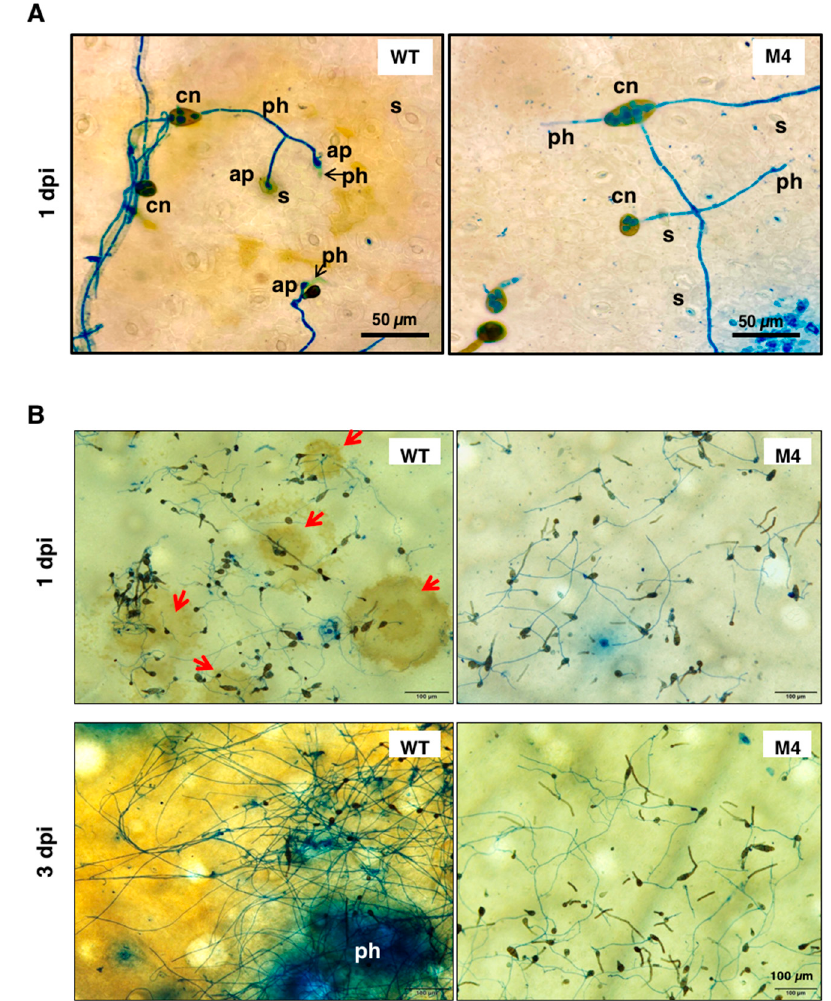
Figure 7. Light microscopy observation of conidia germination on the surface of calamondin leaves. ( A ) Conidia of wild type (WT) and the ∆ pex6 -M4 mutant were placed on citrus leaves and observed by light microscopy, revealing the germination of conidia (cn), the formation of appressorium-like structures (ap) and the penetration of hyphae (ph) through stomata (s) after being staining with lactophenol cotton blue; ( B ) Microscopic lesions (indicated by red arrows) were observed on the surface of citrus leaves inoculated with wild-type conidia 1 day post inoculation (dpi) and coalesced to become large necrotic lesions 3 dpi. Microscopic lesions were rarely observed on citrus leaves inoculated with conidia collected from the ∆ pex6 -M4 mutant.